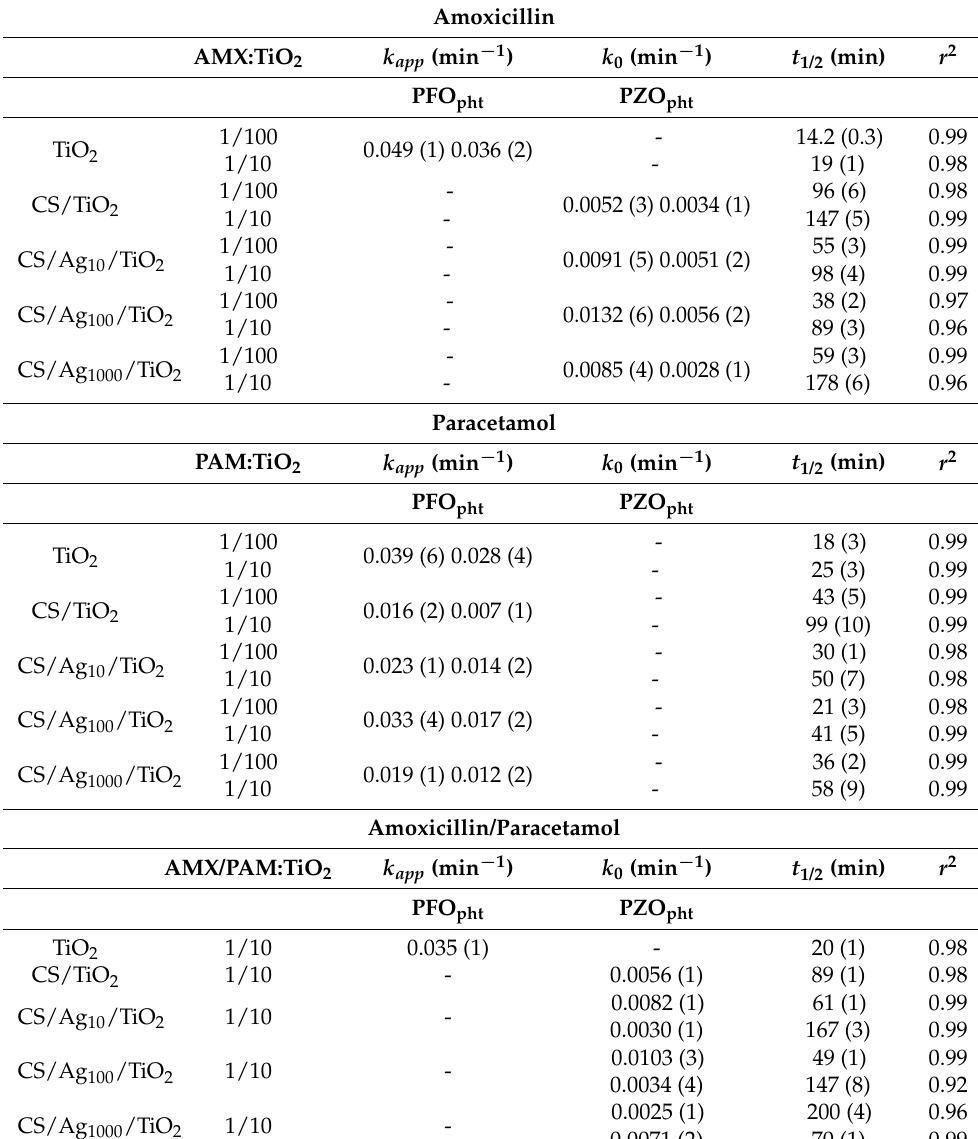
Table 2. Rate constants ( k app for PFO pht and k 0 for PZO pht ), half-lives t 1/2 and r 2 for the photocatalytic degradation measurements for two PhCs:TiO 2 molar ratios. For AMX/PAM on CS/Ag xx /TiO 2 , the two k 0 photodegradation rates are reported. Standard errors on the rate constants are given in